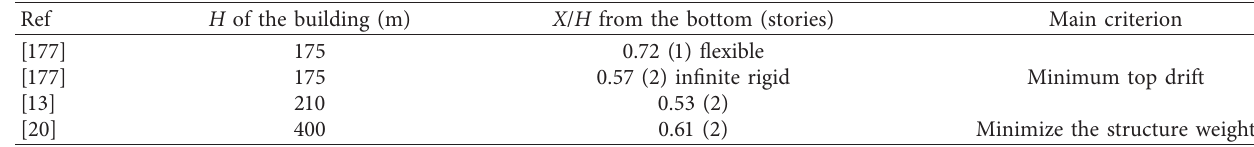
Table 2: RC core walls with one RC